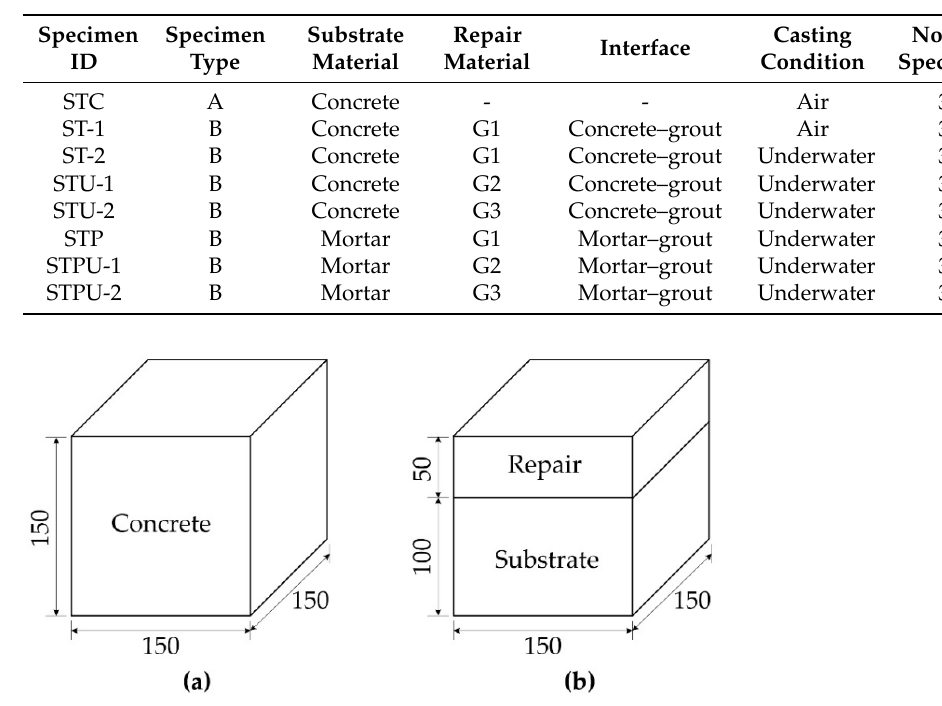
Figure 1. Cubic specimens for bi-surface direct shear test: ( a ) concrete (Type A); ( b ) concrete with repair material (Type B) (unit: mm). repair material (Type B) (unit: mm).